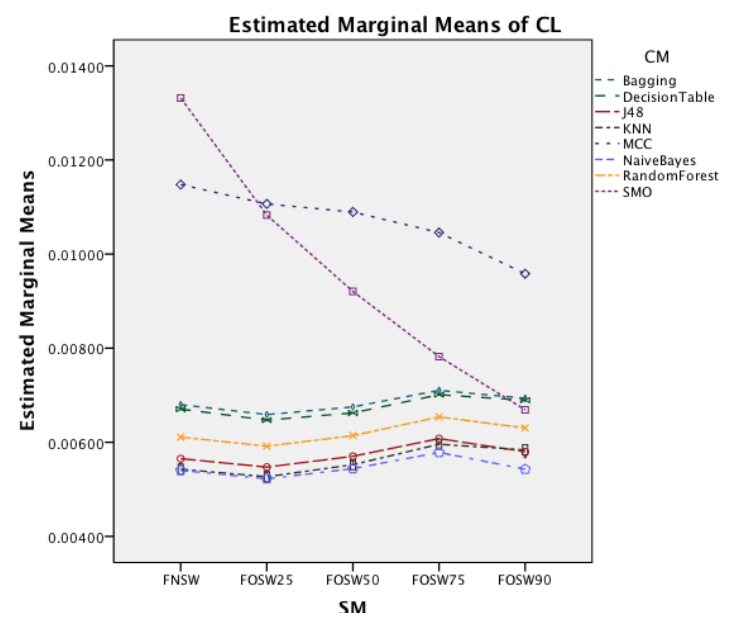
Figure 14. Two-way interaction effect for SM and CM.